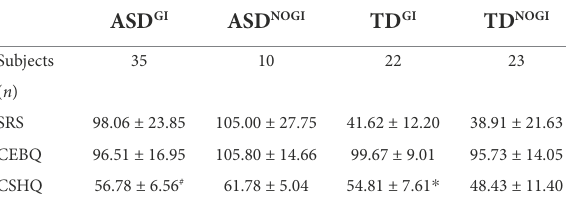
TABLE 3 Gastrointestinal symptoms affected on sociality, eating and